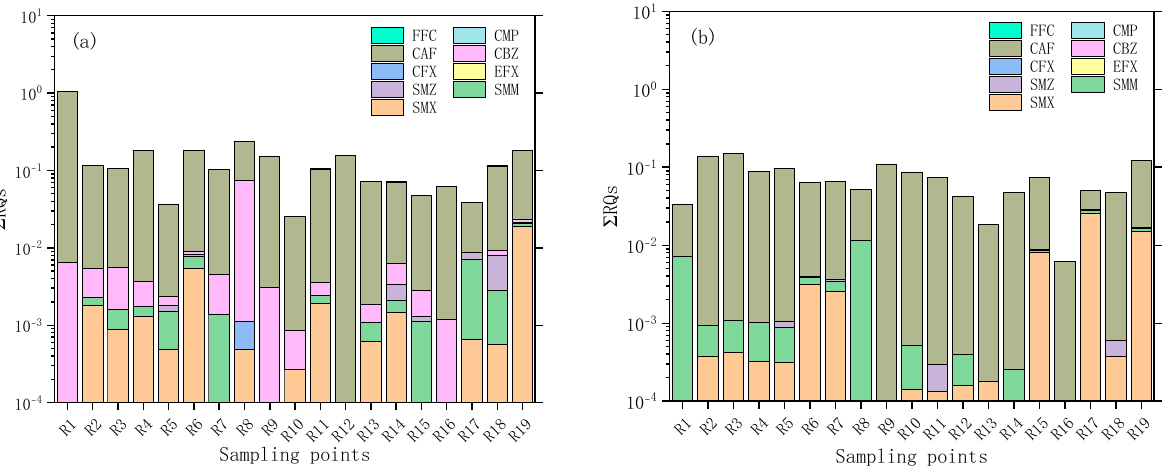
Figure 7. The calculated risk quotients (RQs) for PPCPs in Lianjiang River water during the wet ( a ) and dry ( b ) seasons. The maximum concentrations among the samples were used to calculate the RQs. Insignificant ecological risk (RQs < 0.01), low risk (RQs < 0.1), moderate risk (0.1 < RQs < 1), and high risk (RQs > 1).